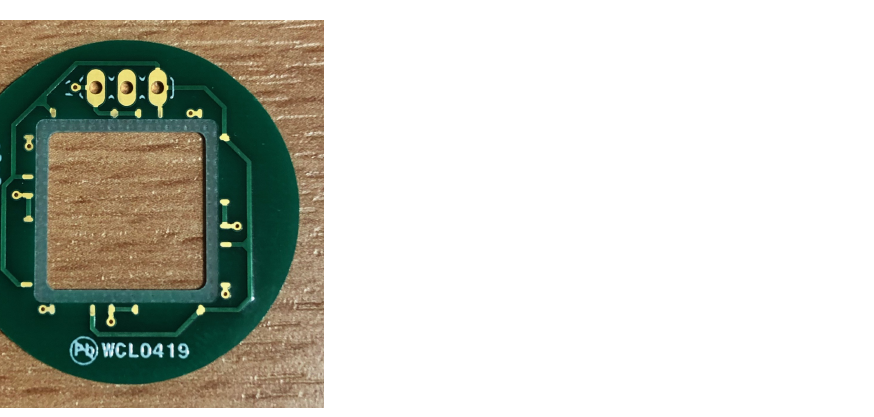
Figure 14. PCB specifically designed to hold the device with frame, staircase actuators, and di-